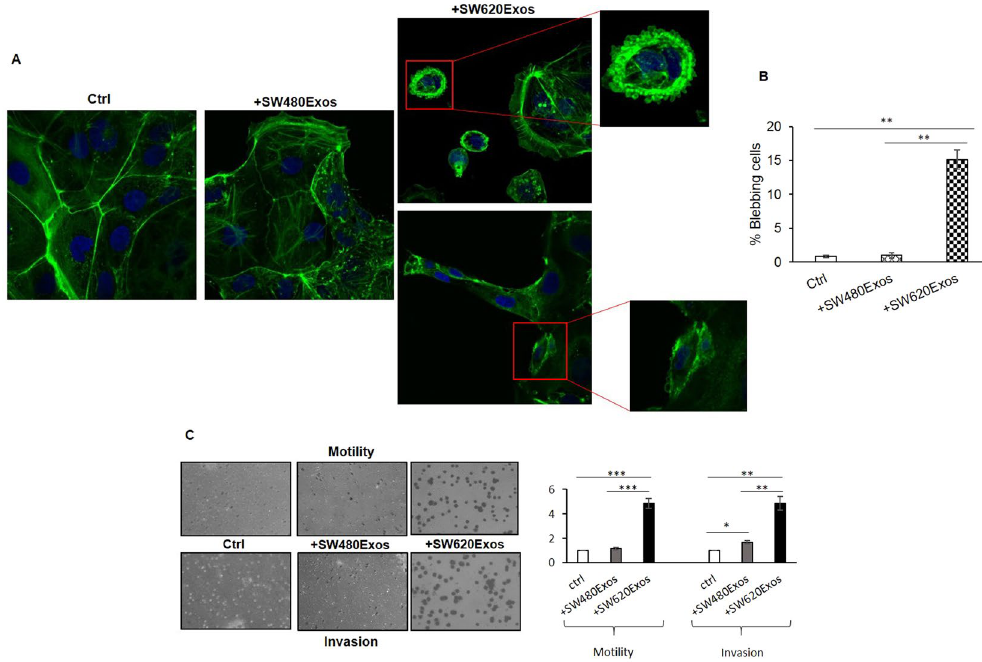
Figure 4. SW620Exos affect morphological and functional properties of Caco2. ( A ) Confocal micrographs of Caco2 cells treated or not for 6 hrs with 20 μ g/ml of SW480Exos or SW620Exos. Cells were stained with Actin green (green) and nuclear counterstaining was performed using Hoescht (blue). ( B ) Percentage of Caco2 blebbing cells after exosome treatment and in control condition. The percentage of blebbing cells was obtained by counting 5 different fields for each condition. ( C ) Transwell migration and invasion assay of Caco2 cells treated with 20 µ g/ml of SW840Exos or SW620Exos. Representative micrographs (left panels) and quantitative data (right panel) are reported for each assay. Ctrl (Control): Caco2 cells without exosome treatment. Values reported in the graphs are the mean ± SD of 5 fields in three independent experiments. Statistical significance was calculated as indicated by the horizontal lines; * p ≤ 0.05, ** p ≤ 0.01, *** p ≤